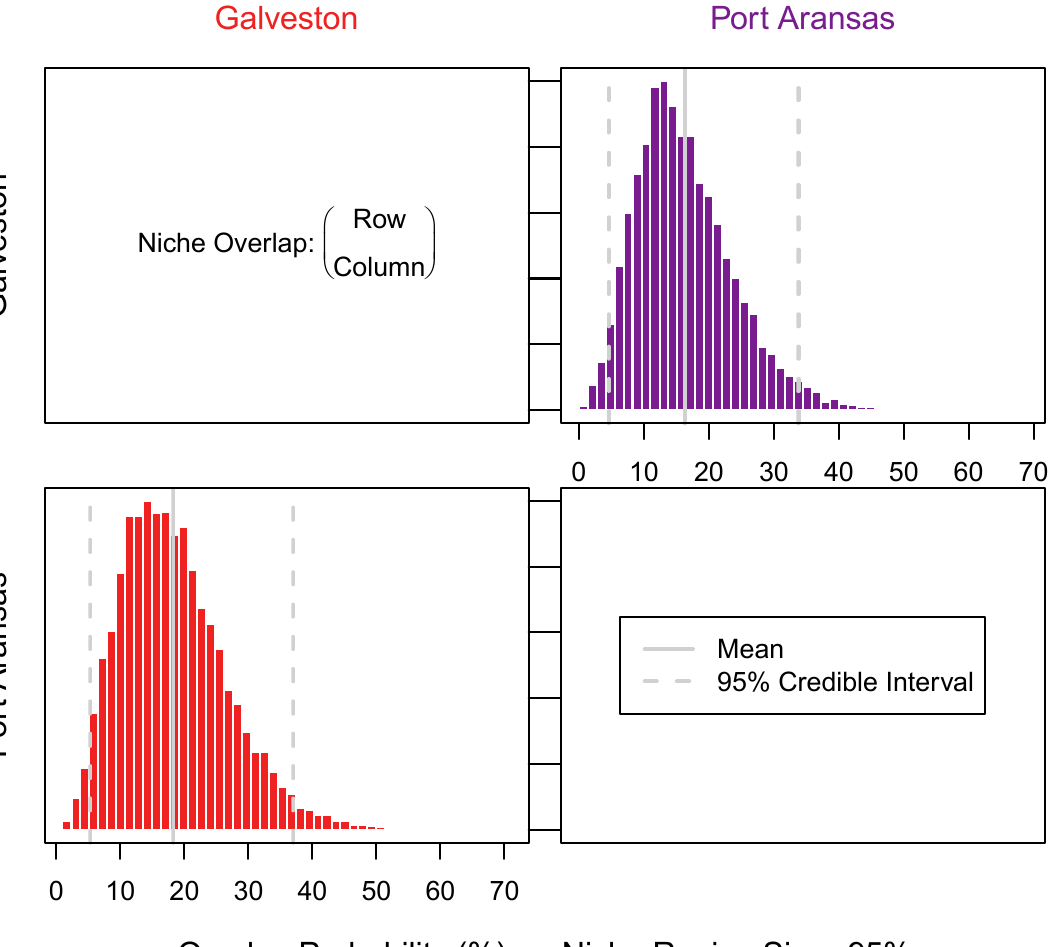
Figure 4. Niche overlap measured pairwise across sheepshead from both locations. Niche overlap was estimated using the 95% confidence interval of the total niche size using 10,000 random Monte Carlo draws of the niche size derived from the combined stable isotope ( δ 13 C, δ 15 N, and δ 34 S) values measured in muscle samples. Additionally, niche size was determined as row over column to estimate the proportion of sheepshead from one location (row) that was overlapped by sheepshead from another location